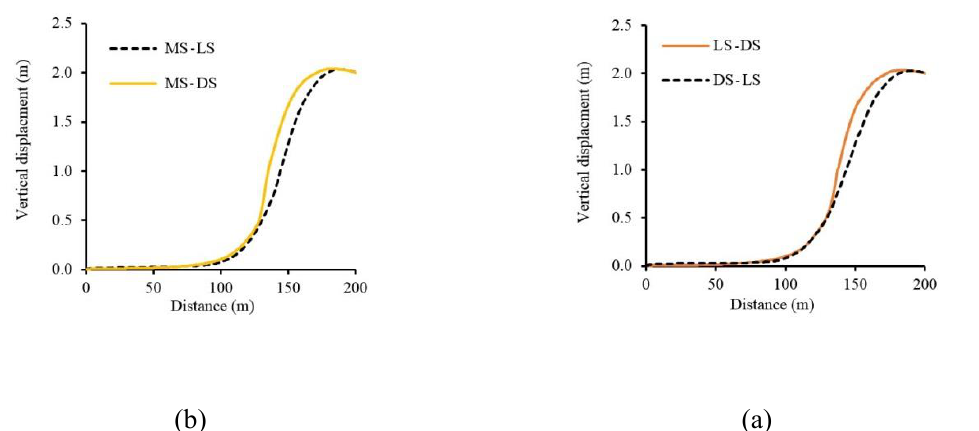
Fig. 11. vertical displacement of ground with two-layer structure: (a) LS-DS and DS-LS, (b) MS-LS and